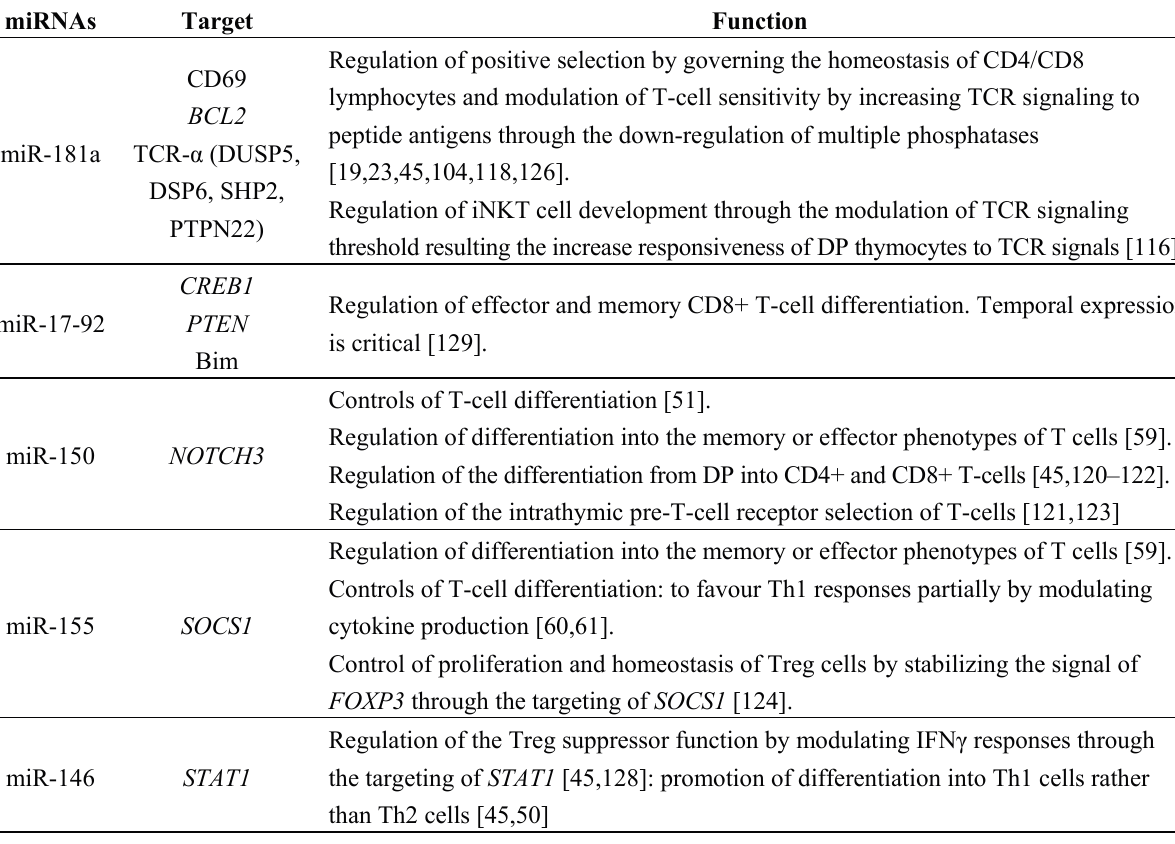
Table 2. The main miRNAs involved in the different stages of T cell